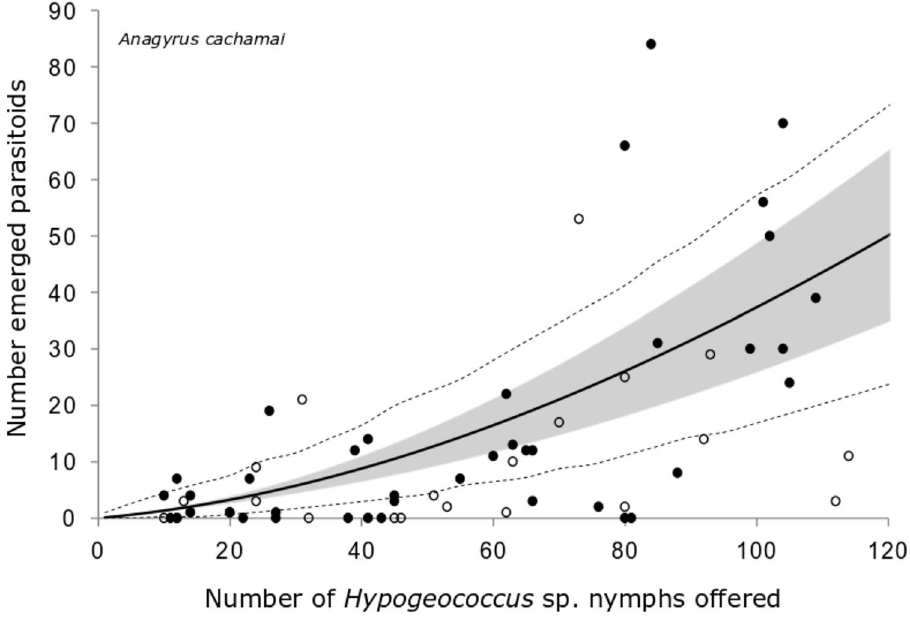
Figure 1. Observed functional response of the parasitoid Anagyrus cachamai attacking Hypogeococcus sp. nymphs . Solid line indicates the mean estimation of functional response, grey area indicates its credibility interval, and dashed line indicates the a posteriori credibility interval for individual measurements. White circles are the observed number of emerged parasitoids in interaction experiments, while dark circles are the number of parasitoids emerged in experiments without interaction.